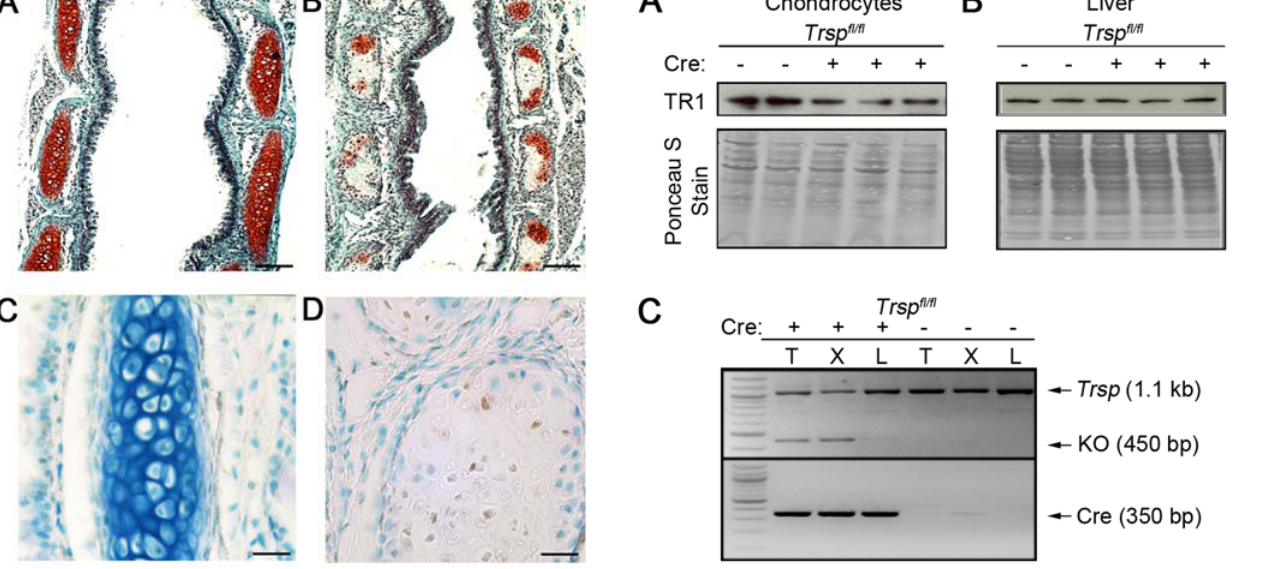
Figure 6. Tracheomalacia and airway lumen narrowing in Trsp fl/fl Col2a1-Cre mice. (A) Triple-stained section of a trachea from a representative Trsp fl/fl (control) mouse, showing normal cartilage ring cross-sections with abundant cells and glycosaminoglycan deposition in the extracellular matrix (indicated by red staining); the connective tissue is stained green. (B) Tracheal rings from a representative Trsp fl/fl Col2a1-Cre mouse were reduced in size, and showed a dramatic loss of red staining as well as chondrocyte depletion; dystrophic calcification was also present in some cartilage rings, for example, the dark staining region in uppermost ring on the right side of the trachea in (B). The lumen of the Trsp fl/fl Col2a1-Cre tracheas was also narrowed. TUNEL positive cells were not evident in the control tracheal cartilages (C), however, scattered TUNEL positive chondrocytes were present within areas of chondronecrosis within Trsp fl/fl Col2a1-Cre tracheal rings (D). Methyl-green counterstaining, used to indicate positions of cell nuclei, also revealed loss of extracellular matrix staining in the Trsp fl/fl Col2a1- Cre rings (D) consistent with chondrocyte dysfunction or death. Scale bars are 450 m m (A and B), and 27 m m (C and D).